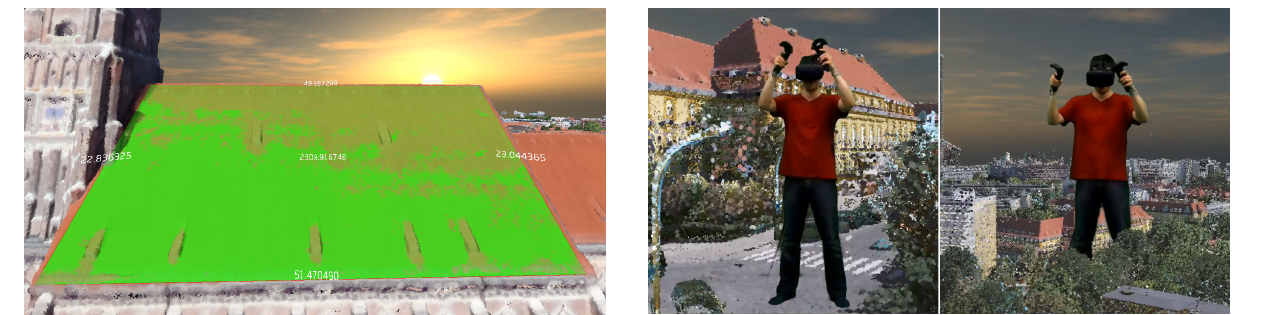
Figure 3. The precise measurement tool allows measuring both distances and areas by point selection.